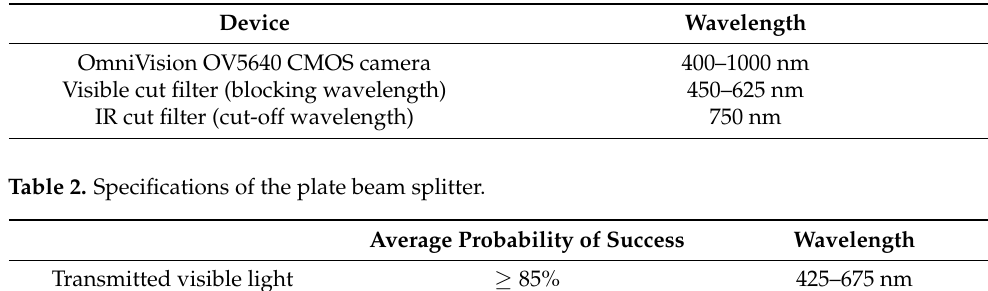
Table 1. The wavelength of camera device and filters.